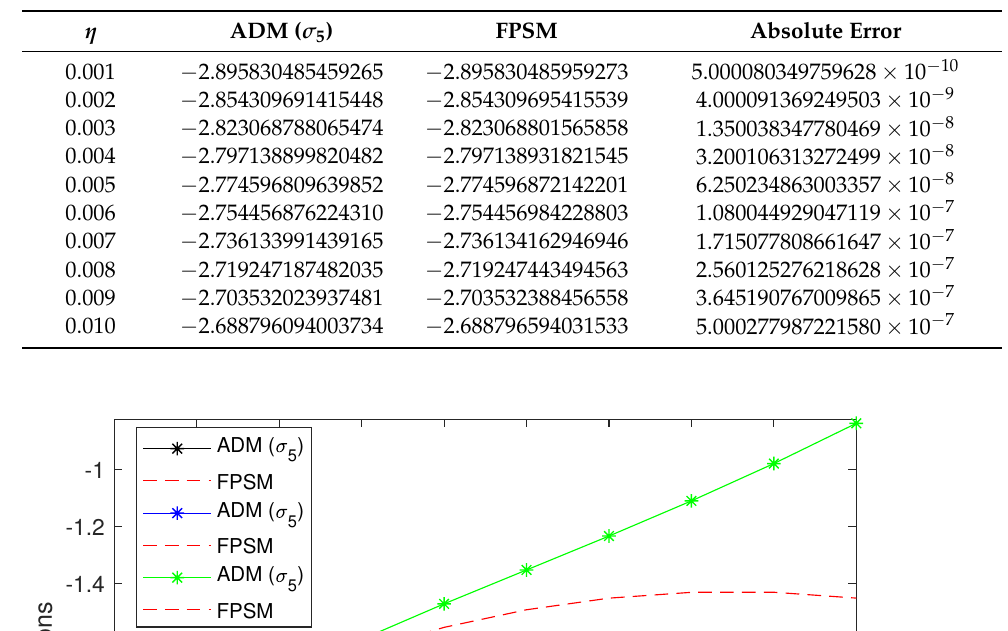
Table 1. Comparison of the numerical solutions and absolute errors for Equation (32).